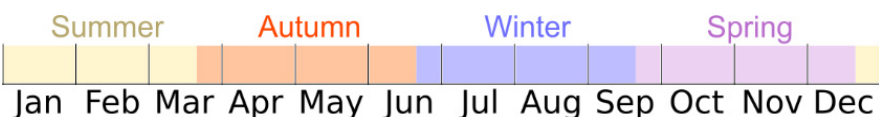
Figure 2. Four subdivisions of the periods of the year for the Brazilian territory. Hot and rainy summers, dry winters and windy autumns. Source: own